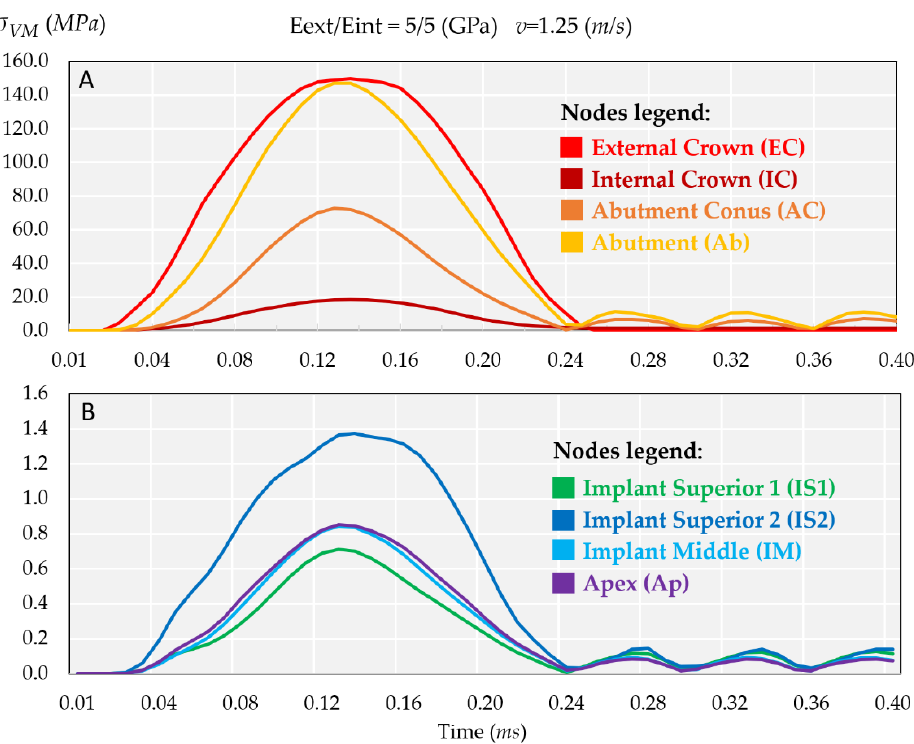
Figure 3. Comparison of the dynamic behavior of Von Mises stress, see Figure 4 for nodes’ locations. ( A ) Four superior nodes. Note the significant difference in stress between the external crown (EC) and the internal crown (IC). ( B ) Four inferior nodes. Note the difference in stress between the apex (Ap) and the implant superior 2 (IS2) nodes.